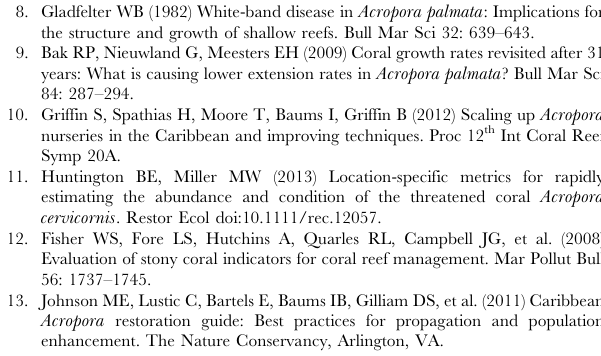
Figure S1 Field measurements and growth of staghorn frag- ment. Photographs of a staghorn fragment taken after deployment at the Florida nursery (left image) and after 6 months of growth (right image). The yellow segments show the measurements taken. The sum of all of the segments represents the Total Linear Extension (TLE) of the fragment. The fragment on the left has a TLE of 12 cm and 2 branches, the fragment on the right has a TLE of 32 cm and 8 branches. The annual growth of this fragment was calculated at 40 cm per year. The annual productivity was calculated at 3.3 cm of new coral/cm of initial coral. The images were taken by J. Herlan. The figure was composed based on the guidelines for the estimation of TLE proposed by Johnson et al. [13]. Data S1 Size and number of branches of the staghorn corals included in this